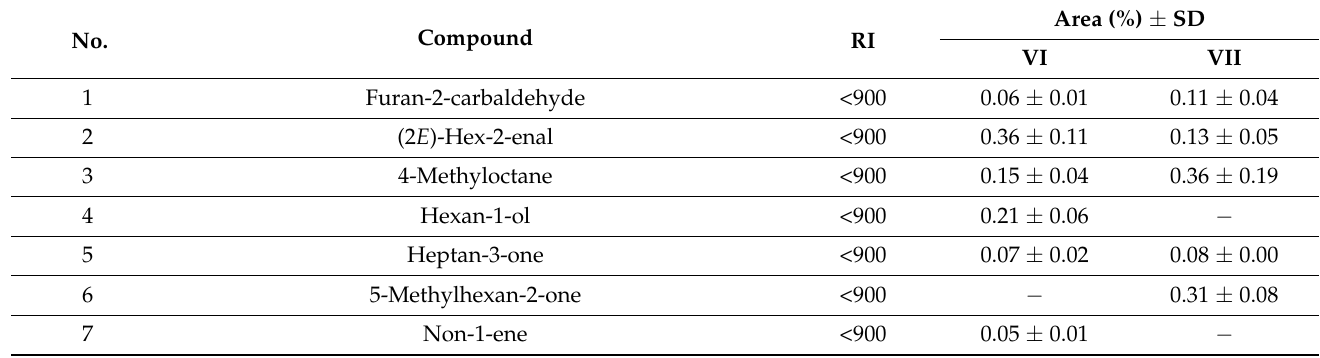
Table 2. The volatile compounds from C. adhaerens isolated by hydrodistillation (HD) and analysed by gas chromatography– mass spectrometry (GC-MS): (VI—hydrodistillate of fresh C. adhaerens , VII—hydrodistillate of air-dried C. adhaerens ).